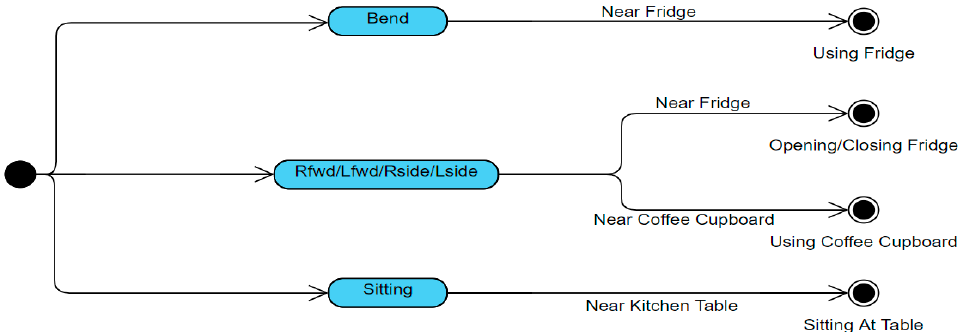
Figure 2. Overview of the activity inference process.